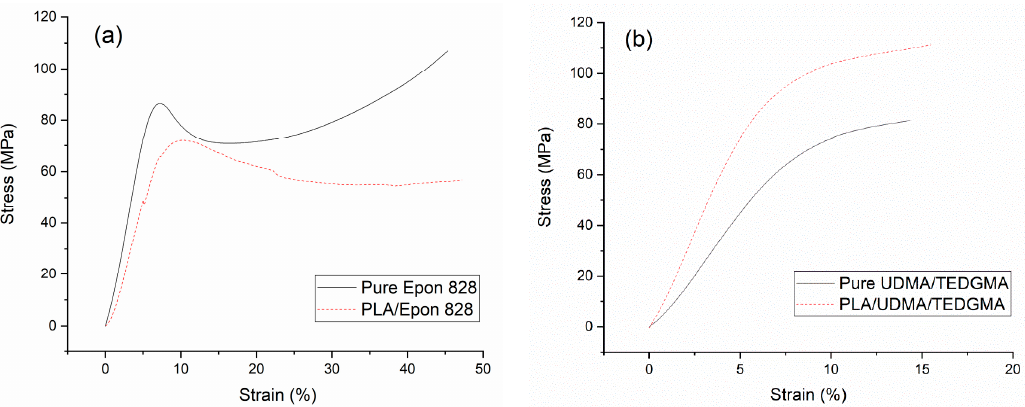
Figure 5. Compression stress-strain curves: ( a ) the solid line curve corresponds to the pure Epon 828 resin specimen (Type 1) and the short dash line curve to the PLA/Epon 828 specimen (Type 2); ( b ) the solid line curve corresponds to the UDMA/TEGDMA resin specimen (Type 3) and the short dash line curve to the PLA/ UDMA/TEGDMA specimen (Type 4).